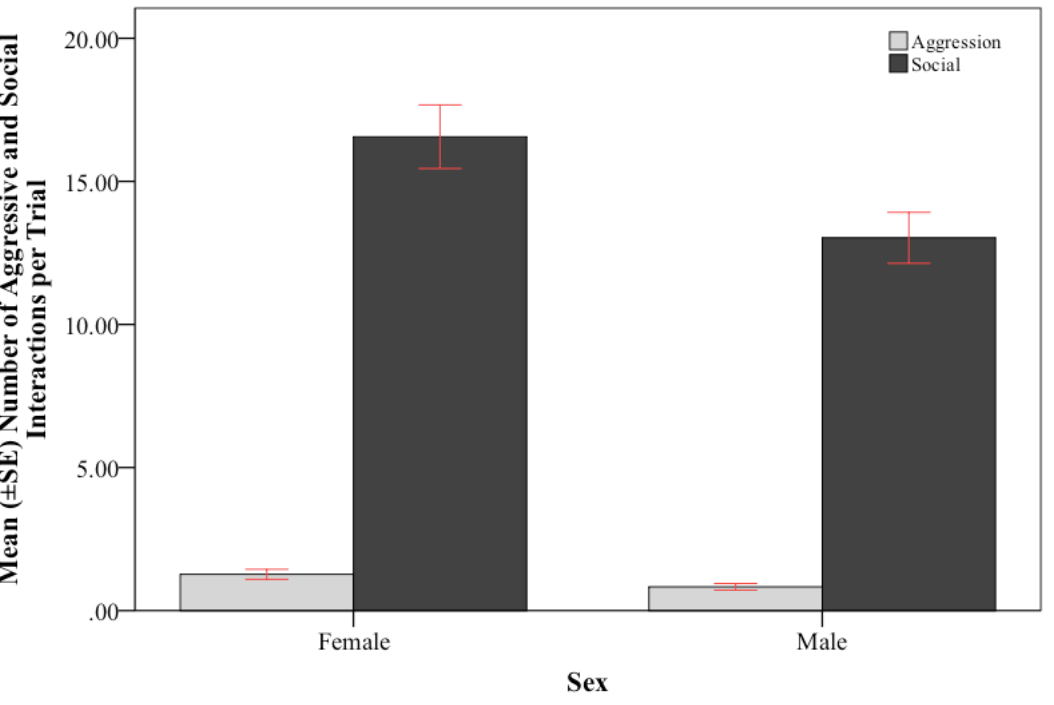
Figure 5. Mean (± 1 SE) number of aggressive and social interactions with the apparatus per trial ( n = 10) exhibited by male and female